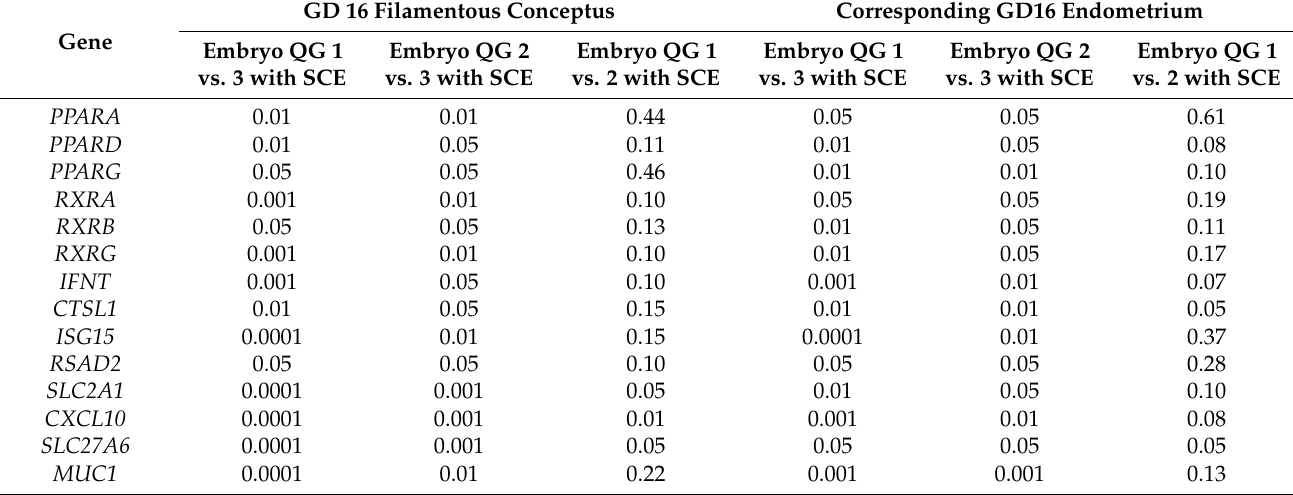
Table 2. ( a ) p -values of pairwise comparisons of mRNA expressions in gestational day (GD) 16 filamentous conceptus 1 and corresponding endometrium in repeat breeder cows 2 with subclinical endometritis 3 following transfer of different GD 7 embryo quality grades (QG) 4 . ( b ) p -values of pairwise comparisons of mRNA expressions in gestational day (GD) 16 filamentous conceptus 1 and corresponding endometrium in repeat breeder cows 2 without subclinical endometritis 3 following transfer of different GD 7 embryo quality grades (QG) 4 . ( c ) p -values of pairwise comparisons of